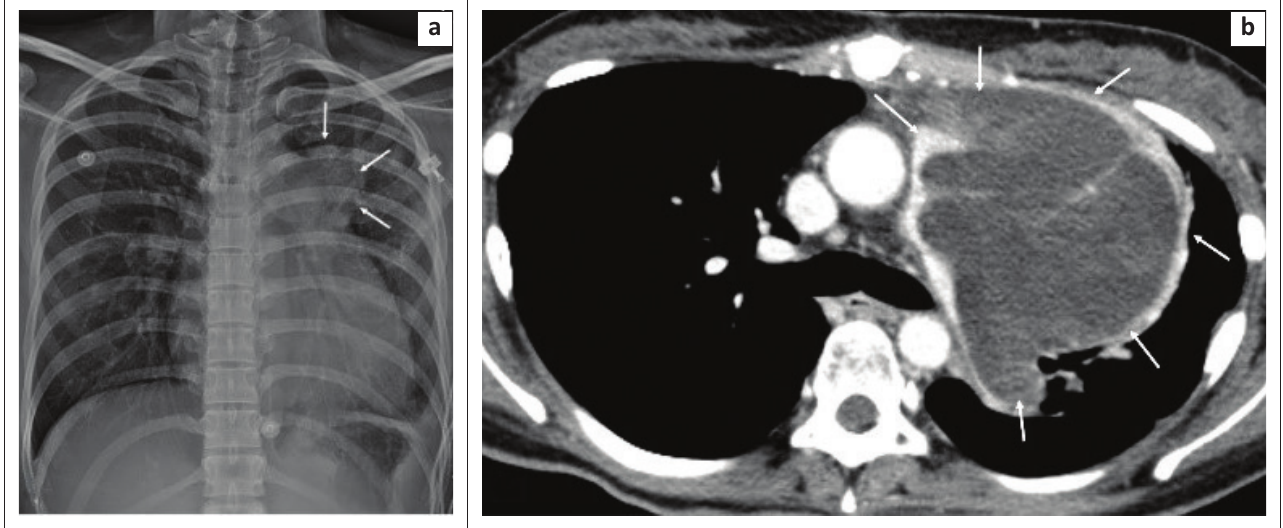
FIGURE 2: (a) Follow-up frontal chest radiograph revealed an enlarged main pulmonary artery and a left hilar mass (arrows). (b) Axial computed tomography pulmonary angiography demonstrated a large lobulated rim enhancing exophytic mediastinal mass extending from the dilated main pulmonary artery and the left pulmonary artery